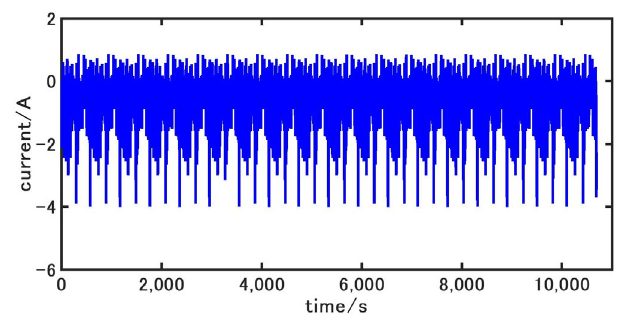
Figure 8. Current of US06 Driving Condition.